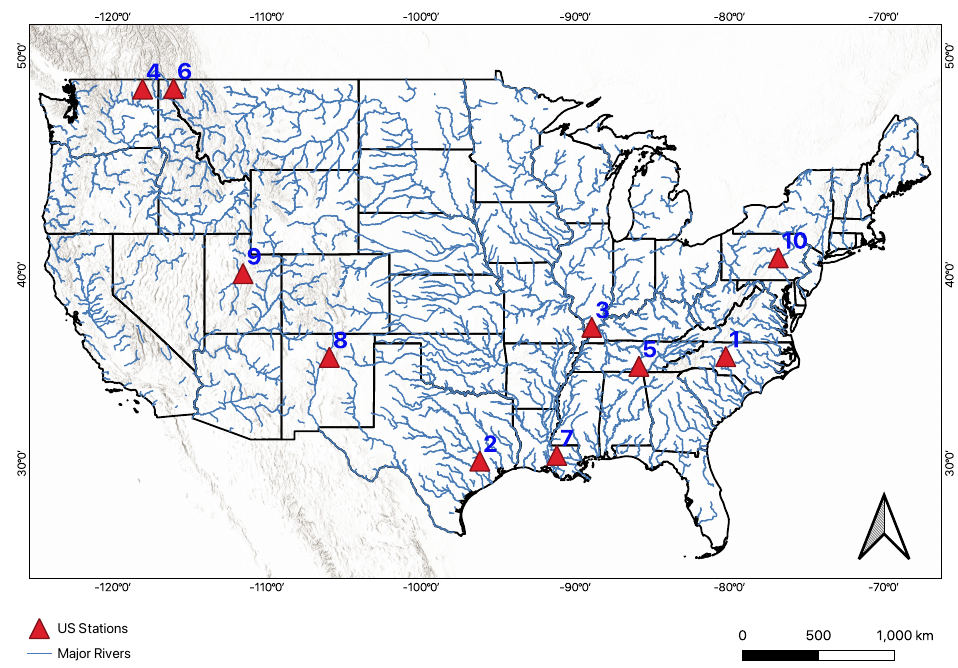
Figure 2. Map shows stations (in the red triangle) in the US over which we applied the methods developed in this